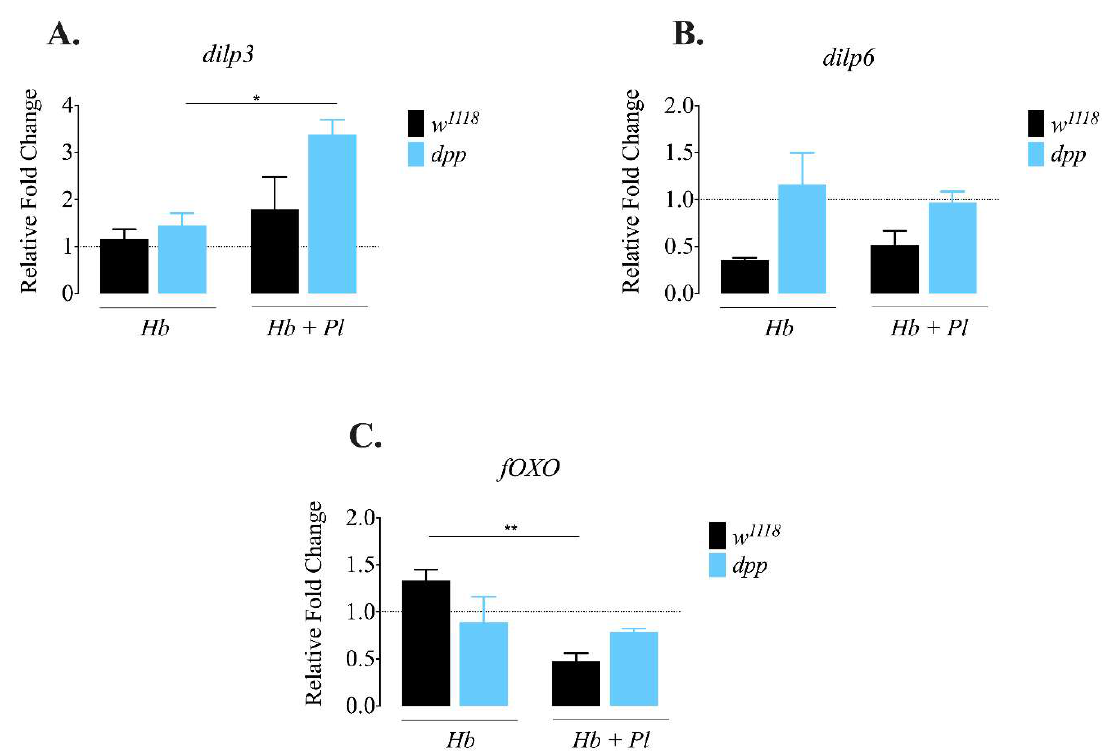
Figure 3. Expression of dilp3 , dilp6 and fOXO in Drosophila melanogaster dpp mutant and background control larvae 24 h after infection with axenic ( Heterorhabditis bacteriophora , Hb ) or symbiotic ( Heterorhabditis bacteriophora + Photorhabdus luminescens , Hb + Pl ) nematodes. ( A ) Expression of dilp3 increases in dpp mutant larvae infected with symbiotic H. bacteriophora compared to dpp mutants infected with axenic H. bacteriophora (* p = 0.0486). ( B ) There is no significant change in the expression of dilp6 in dpp mutant larvae infected with either axenic or symbiotic nematodes compared to their background control ( w 1118 ). ( C ) Expression of fOXO is reduced in background control larvae ( w 1118 ) infected with symbiotic H. bacteriophora compared to background control larvae infected with axenic nematodes (** p = 0.0098). Dotted line at 1 indicates normalization of fold change relative to uninfected controls. The experiments were performed in biological duplicates and repeated three times (N=30- 42).